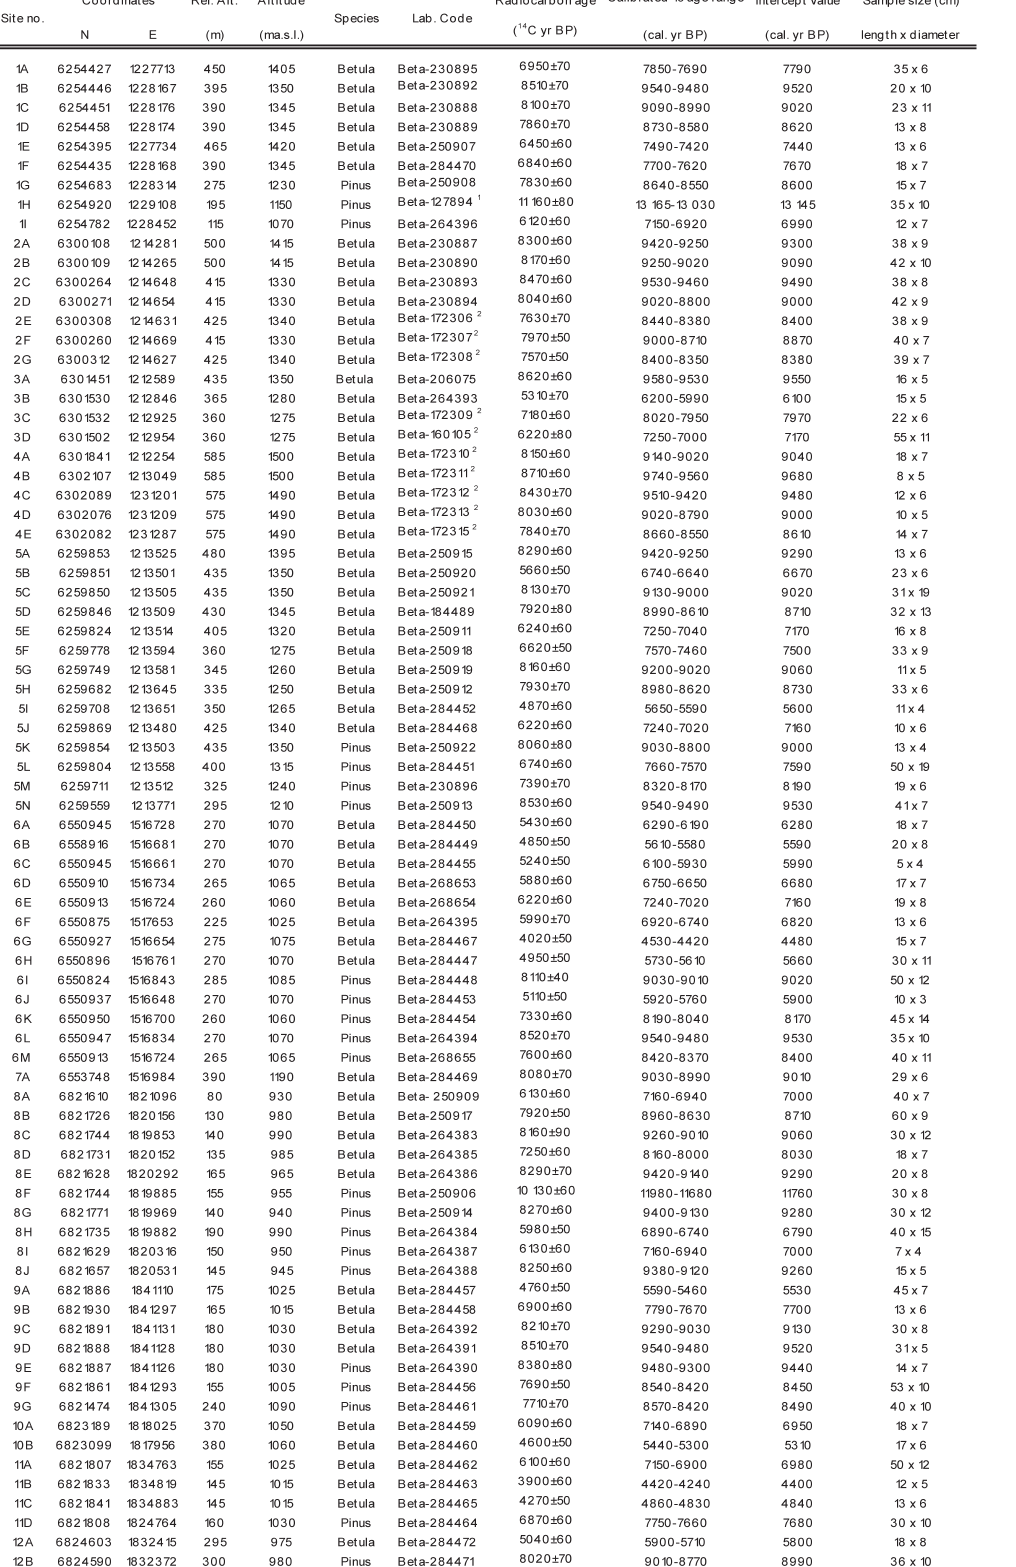
Table 1: Radiocarbon dates of megafossil tree remains retrieved from the forefields of glaciers and snow/ice patches in the three main study areas. “Rel. alt.” means altitude relative to present day treeline. Foot notes 1 and 2 refer to Kullman & Kjällgren (2000) and Kullman (2004),